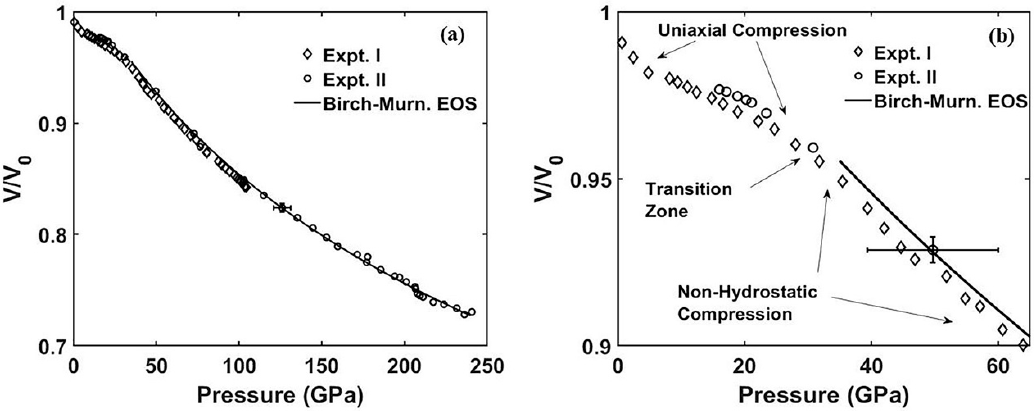
Figure 3. ( a ) Pressure-volume curve for Experiments I and II fitted with a 3rd order Birch–Murnaghan equation of state (EOS) above 35 GPa. ( b ) Pressure-volume curve for Experiments I and II for pressures below 65 GPa. Regions of uniaxial compression and non-hydrostatic compression are labeled along with the 3rd order Birch–Murnaghan equation of state (EOS) above 35 GPa.